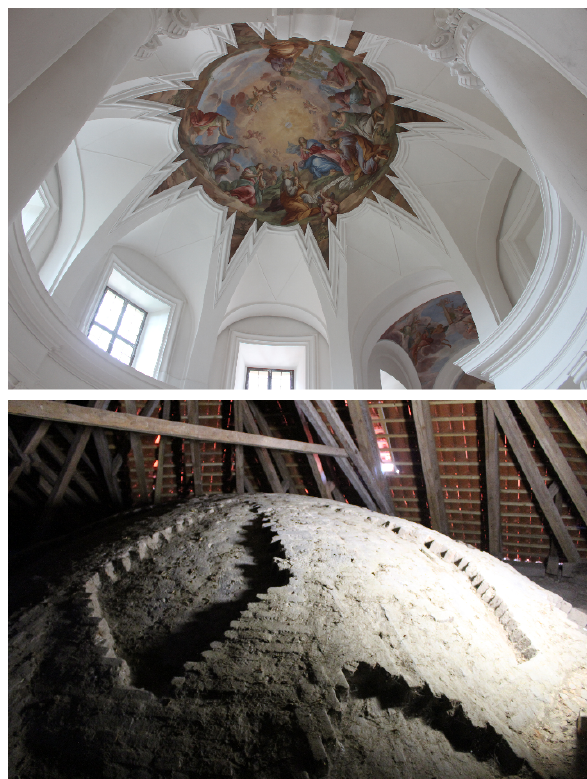
Figure 1. The intrados (top) and extrados (bottom) of the star vault covering the St. Bernard’s Chapel in the Plasy Monastery